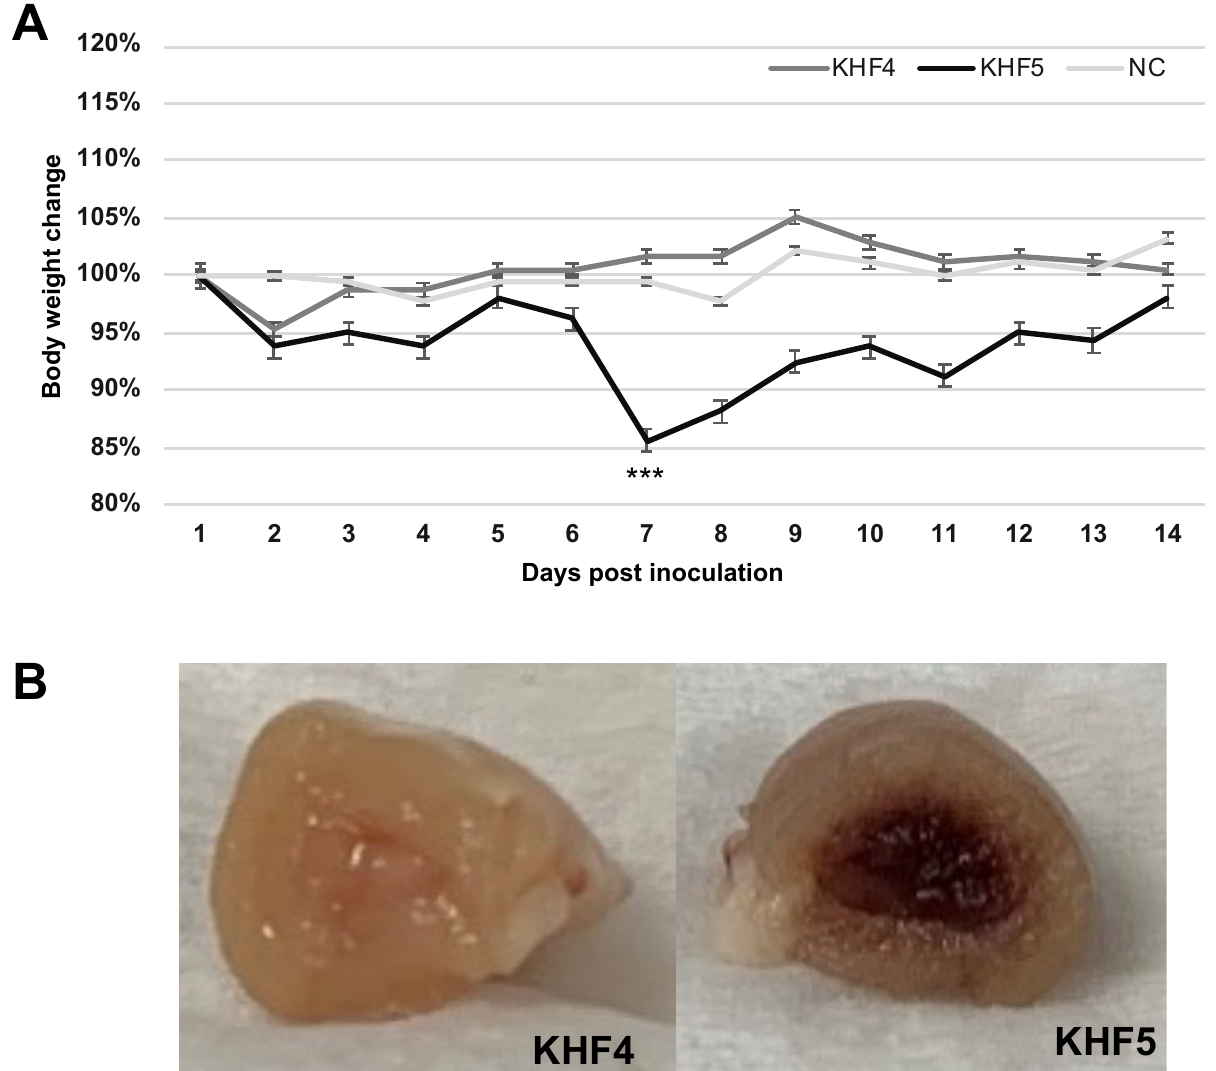
Figure 3. Body weight and renal changes in mice with KHF4 and KHF5 infection. ( A ) Five-week- old BALB/c mice were infected with KHF4 and KHF5 strains, or mock inoculation with culture medium of Veo E6 cells (NC). Subsequently the weight changes were measured between 1 and 14 dpi. *** p < 0.001. ( B ) At 7 dpi, a significant decrease in weight loss was observed, indicating renal hemorrhage.